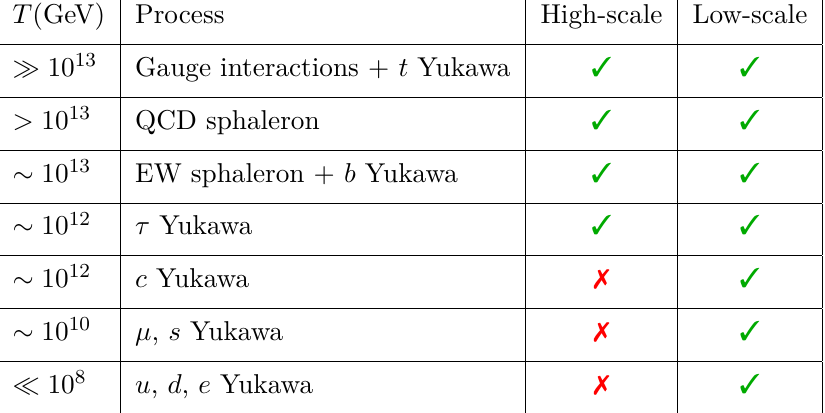
Table 6 . Approximate temperatures at which different SM processes come into equilibrium in the early Universe [87]. Green ticks mark the processes that are assumed to be in equilibrium in the high- and low-scale scenarios, and red crosses mark the interactions that are assumed to not be in